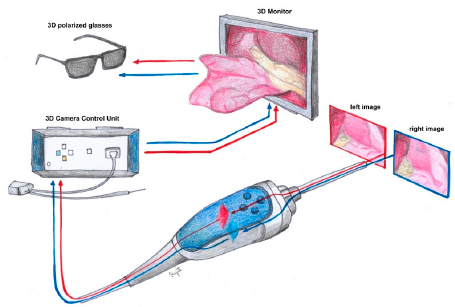
Figure 1. Diagram showing principles of 3D laparoscopy.